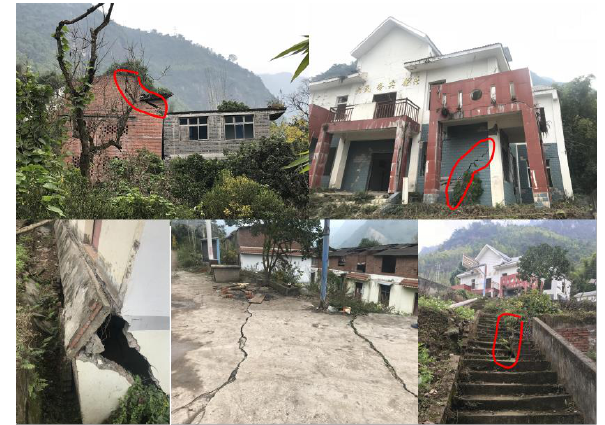
Figure 12. House cracks and ground